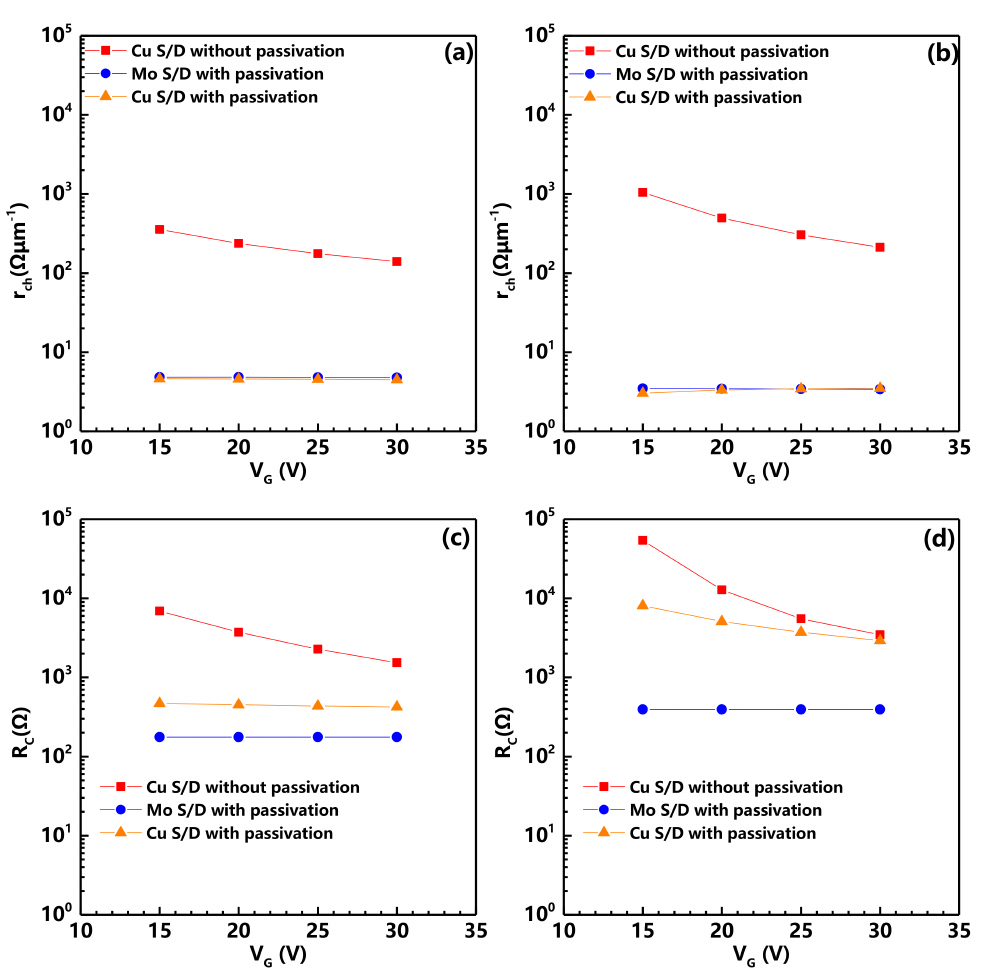
Figure 2. Channel resistance per unit channel length ( r ch ) for a-IGZO TFTs ( a ) before post-annealing and ( b ) after post-annealing, and contact resistance ( R C ) for a-IGZO TFTs ( c ) before post-annealing and ( d ) after post-annealing as a function of V G .